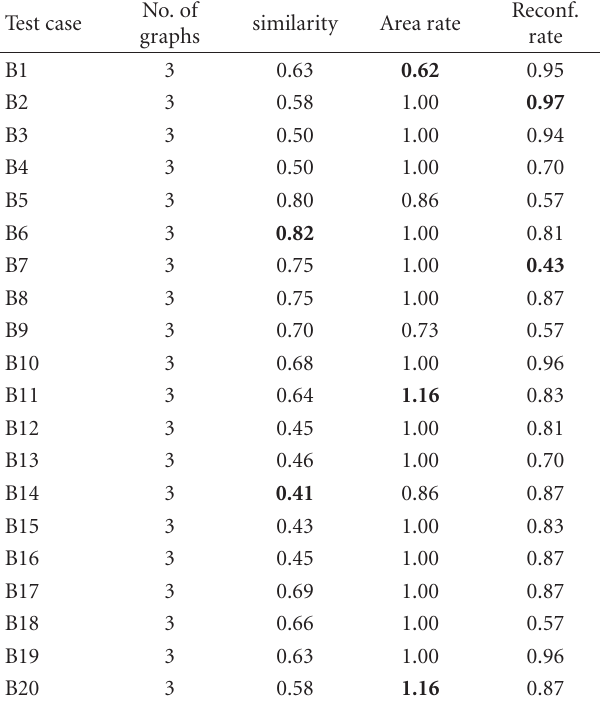
Table 2: Overview of the results of the second set of experiments with three graphs